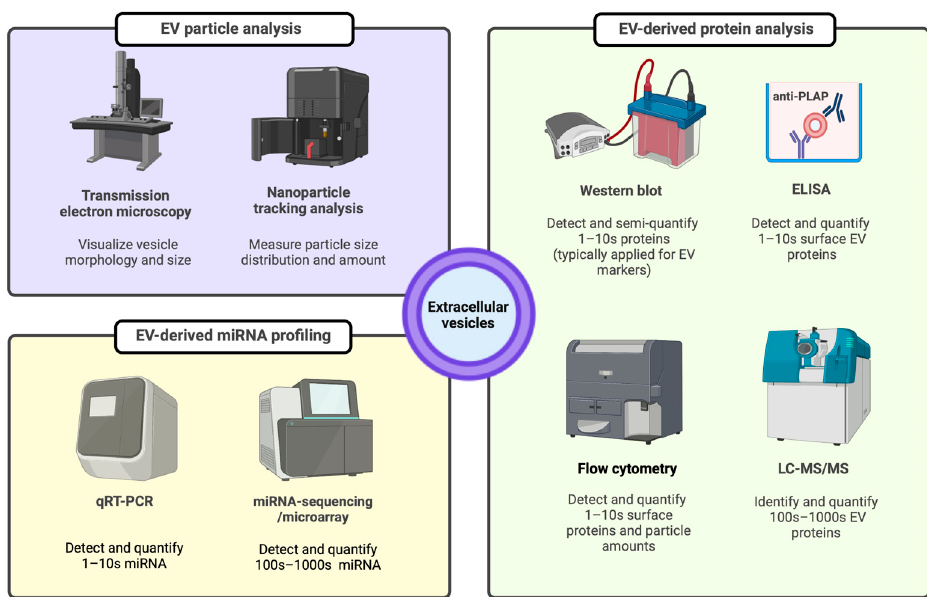
Figure 3. EV characterization methods for particle, protein, and miRNA evidence. ELISA: enzyme linked immunosorbent assay, EV: extracellular vesicle, LC-MS/MS: liquid chromatography-tandem mass spectrometry, miRNA: microRNA, PLAP: placental alkaline phosphatase protein, qRT-PCR: quantitative real-time polymerase chain reaction.